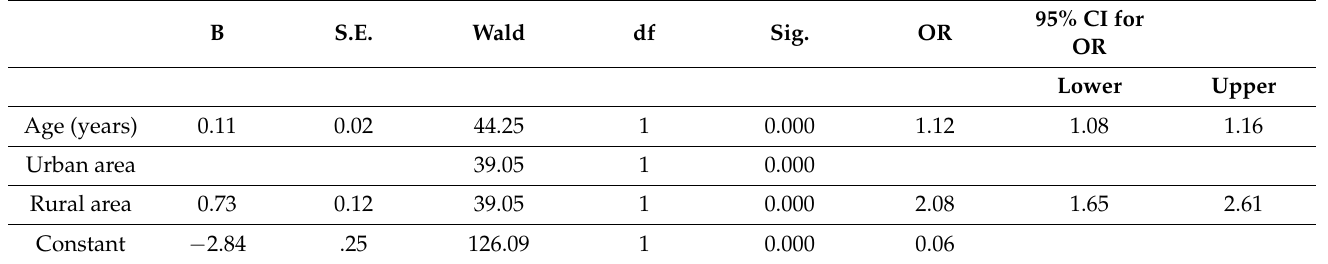
Table 4. Logistic regression model including age, living conditions and H. pylori infection status for pediatric patient with